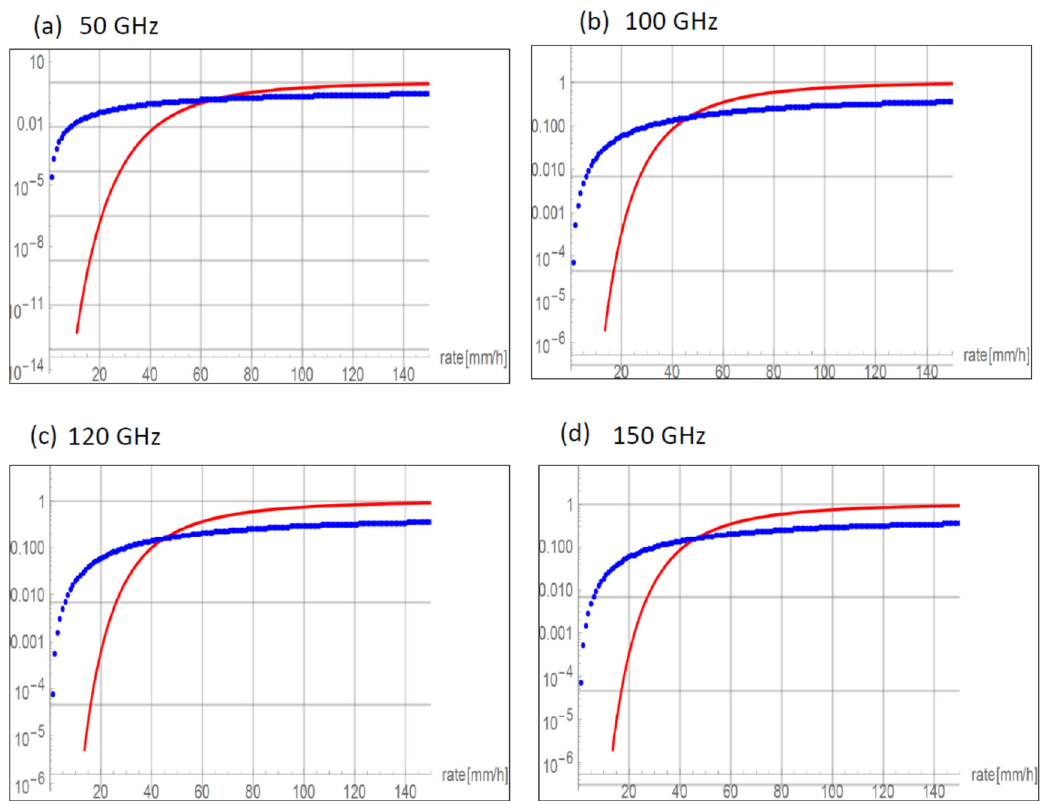
Figure 3. Logarithmic plot comparing probability for symbol error for a range of frequencies. The red solid line is the log of average probability as in (6), and the blue dotted line is the probability considering the pdf for rain, (20). For low rain rate, which would be the practical range for signal transmission, the probability for error is higher if the rain rate is considered. The calculation was performed for M = 64 and for ( a ) 50 GHz, ( b ) 100 GHz, ( c ) 120 GHz, and ( d ) 150 GHz. For higher frequencies, atmospheric disturbance will be more significant, as discussed in the text.